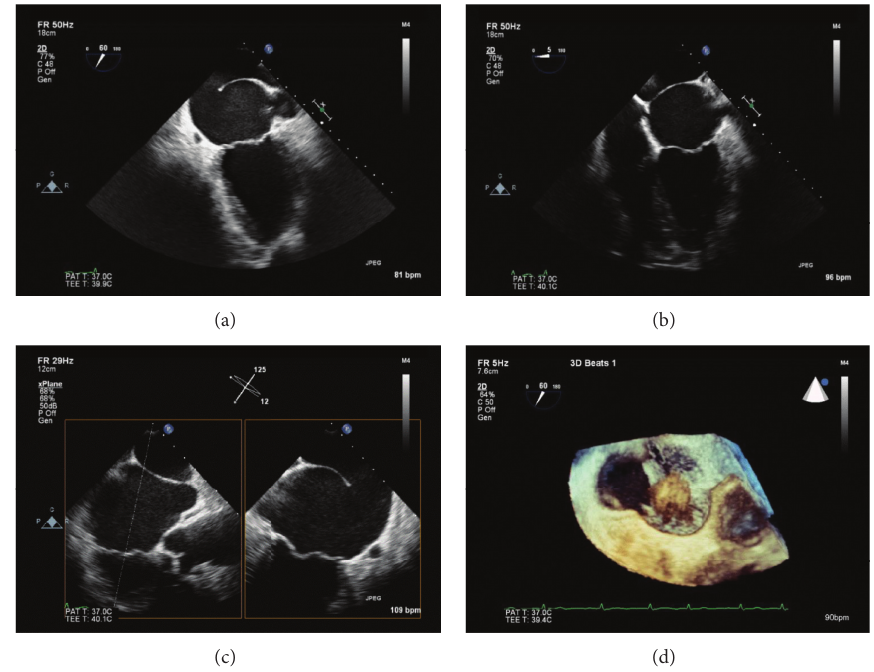
Figure 3: Transesophageal echocardiogram. 2-chamber view (a), 4 chamber view (b), biplane view (c), and 3D mode (d) showing the left atrium divided by a large fenestrated fibromuscular membrane consistent with cor triatriatum